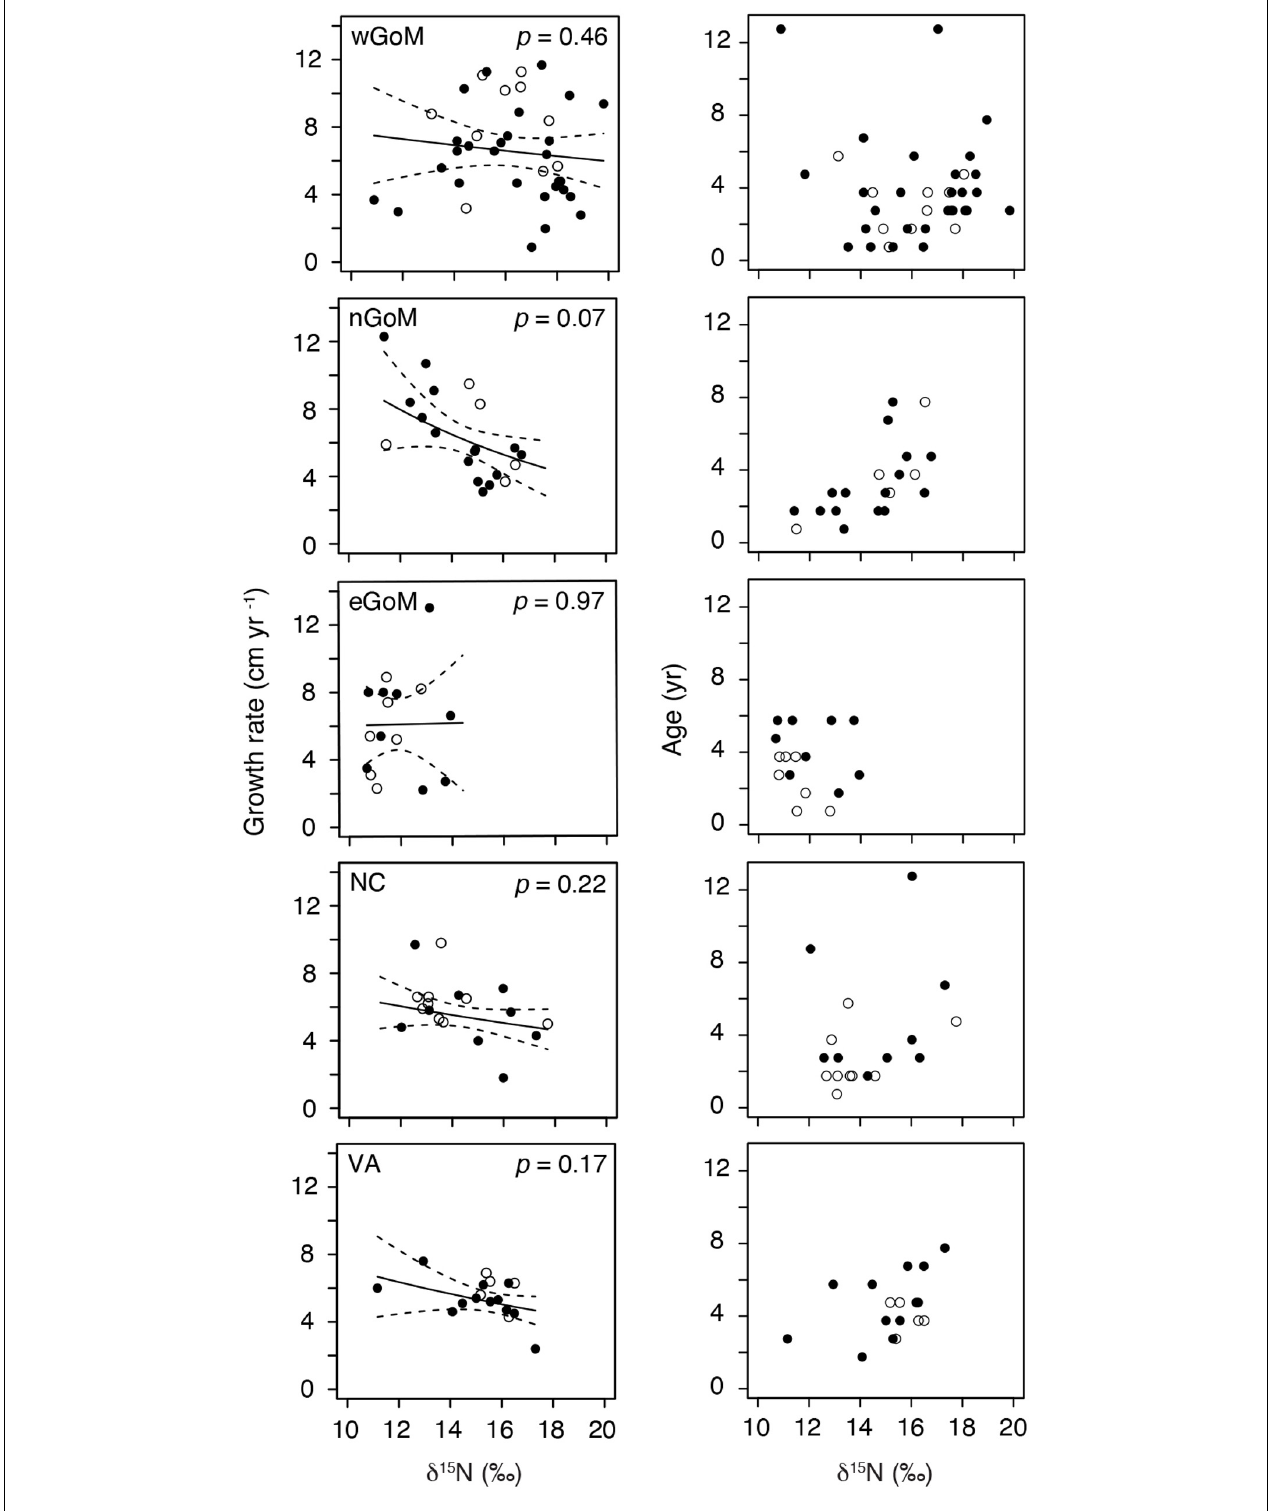
FIGURE 4 | Generalized Linear Model results examining the relationships between annual Kemp’s ridley sea turtle growth rates and δ 15 N values, and age and δ 15 N values, for individual turtles by geographic region. Data are for the most recently deposited growth layer prior to death only. Closed circles are true annual growth rates (i.e., turtle stranded in spring, yielding a complete growth interval). Open circles are estimated annual growth rates for turtles that stranded during the winter (November–March); we assumed that annual skeletal growth asymptotes in November (see section “Somatic Growth Rates in Materials and Methods”).